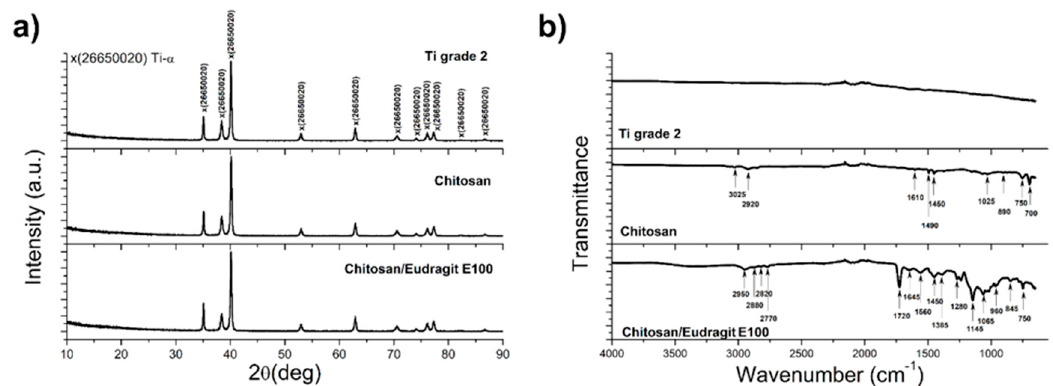
Figure 3. ( a ) X-ray diffractograms and ( b ) FTIR spectra of the Ti grade 2 substrate, the chitosan coating, and the chit/EE100 coating (A1 sample).